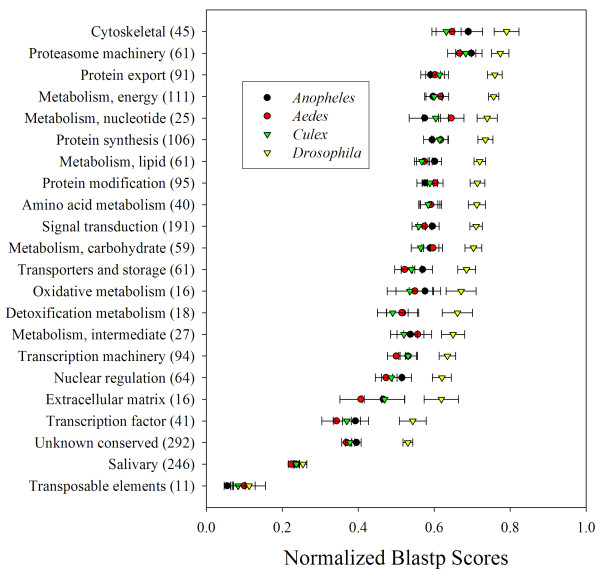
Normalized blast scores of Glossina morsitans morsitans proteins compared to Drosophila melanogaster, and three species of mosquitoes: Anopheles gambiae, Aedes aegypti and Culex quinquefasciatus. Symbols and bars represent the average and standard error of the mean. The number in parenthesis indicates the number of sequences compared for each functional classification.